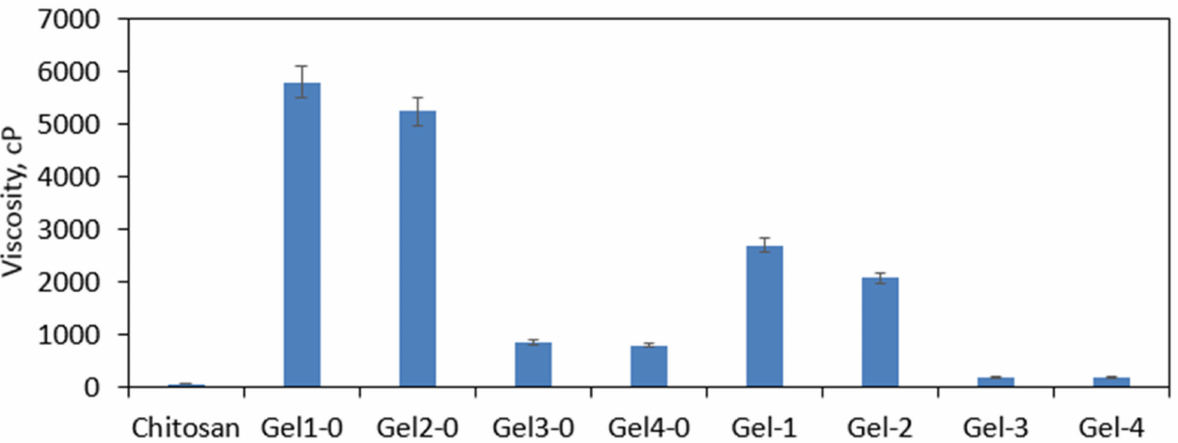
Figure 10. Viscosity study of the raw chitosan, hydrogels after crosslinking (Gel1-0 to Gel4-0), and hydrogels after lyophilization and swelling with distilled water (Gel-1 to